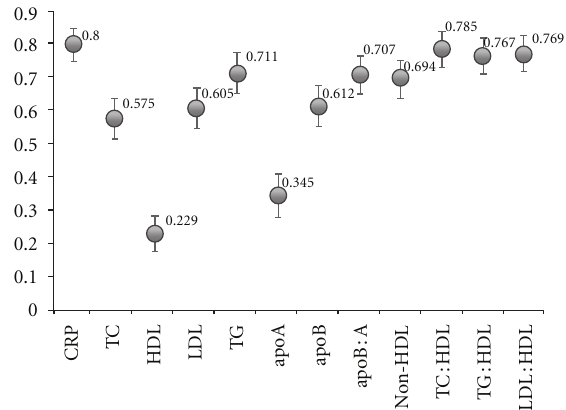
Figure 1: The diagnostic value of measured and calculated variables for the occurrence of acute coronary syndrome. apoA: apolipoprotein A-I; apoB: apolipoprotein B; apoB:A: apolipopro- tein B to apolipoprotein A-I ratio; CRP: C-reactive protein; HDL: high-density lipoprotein cholesterol; LDL: low-density lipoprotein cholesterol; LDL: HDL: low-density lipoprotein cholesterol to high- density lipoprotein cholesterol ratio; nonHDL: non-high-density lipoprotein cholesterol; TC: total cholesterol; TC:HDL: total cholesterol to high-density lipoprotein cholesterol ratio, TG: tri- glycerides; TG:HDL: triglycerides to high-density lipoprotein cholesterol